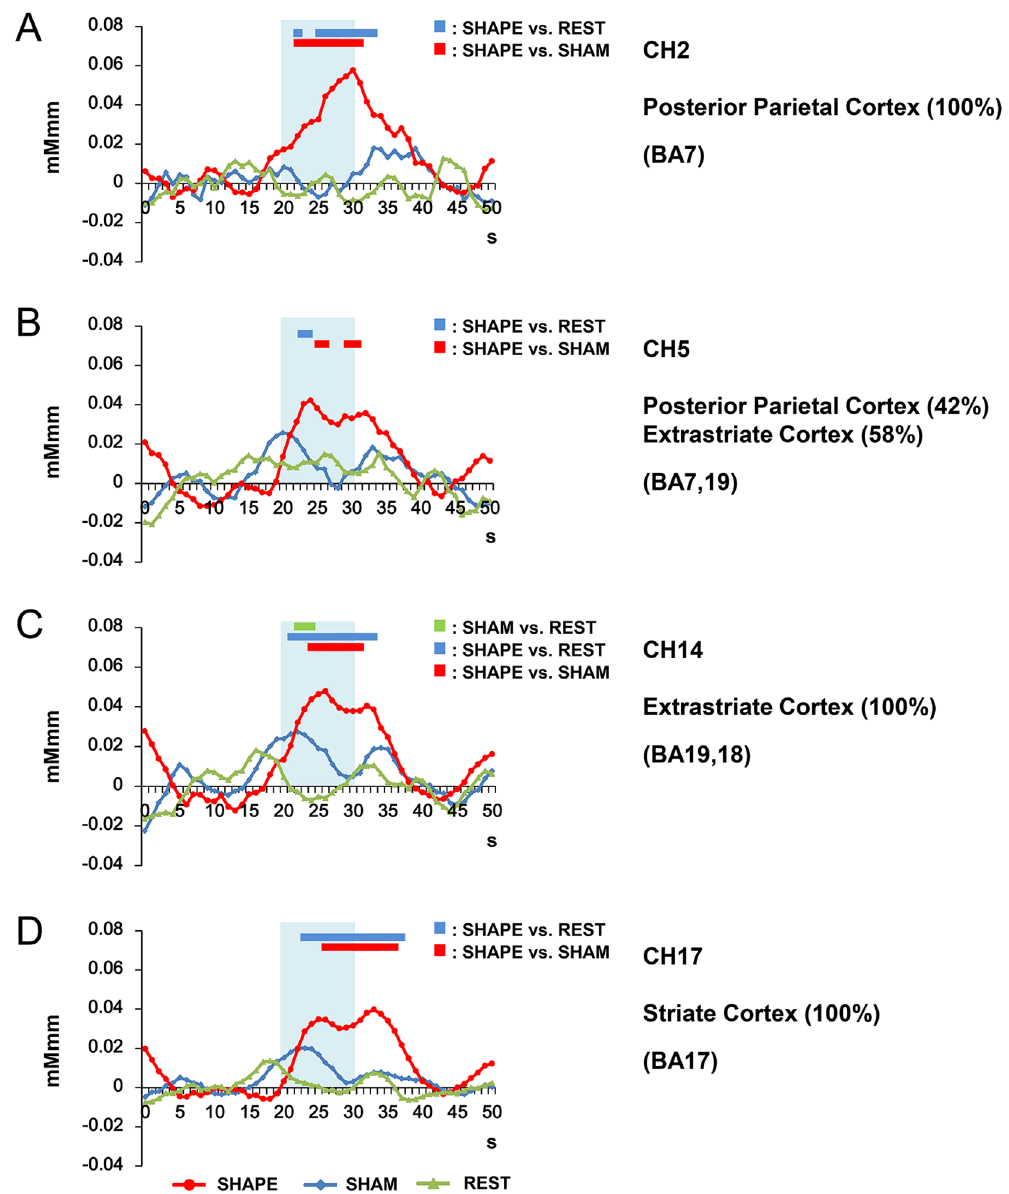
Figure 6. Temporal changes in oxygenated-hemoglobin concentration ([oxy-Hb]). Shown are changes in [oxy-Hb] at channels 2 (A; PPC/ BA7), 5 (B; PPC/extrastriate cortex, BA19), 14 (C; extrastriate BA18), and 17 (D; striate cortex) during the REST, SHAM, and SHAPE sessions. Significant differences between SHAM and REST are indicated by a green bar, between SHAPE and REST by a blue bar, and between SHAPE and SHAM by a red bar. Statistical comparisons were conducted using two-way repeated-measure (ANOVA) of time and condition (SHAPE, SHAM, REST), followed by Tukey’s post-hoc test. The level of significance was set at p , 0.05. Significant differences between SHAPE and SHAM, and SHAPE and REST were clearly present in the posterior parietal, extrastriate, and striate cortices during the task and post-task periods. Blue shading indicates the task